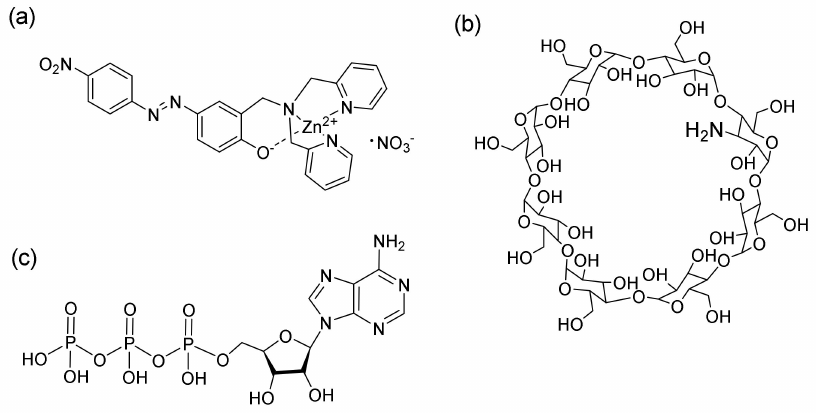
Figure 1. Chemical structures of ( a ) 1-Zn , ( b ) 3-NH 2 - γ -CyD, and ( c )